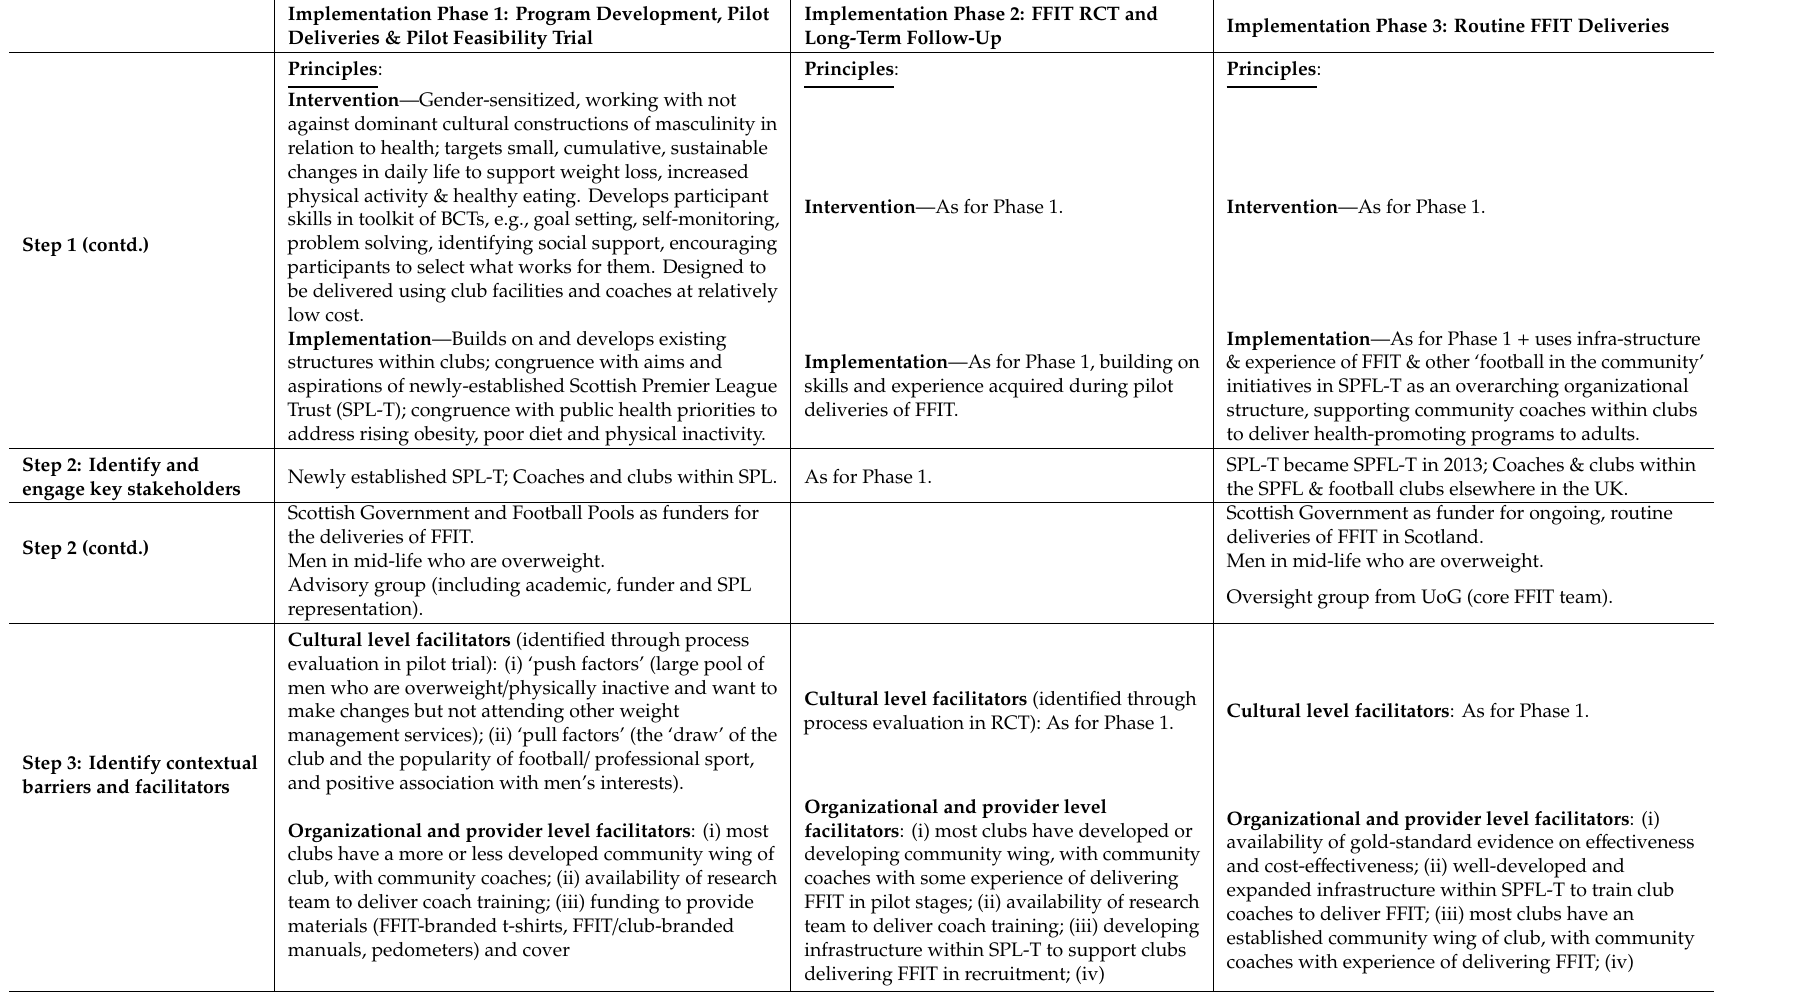
Implementation Phase 3: Routine FFIT